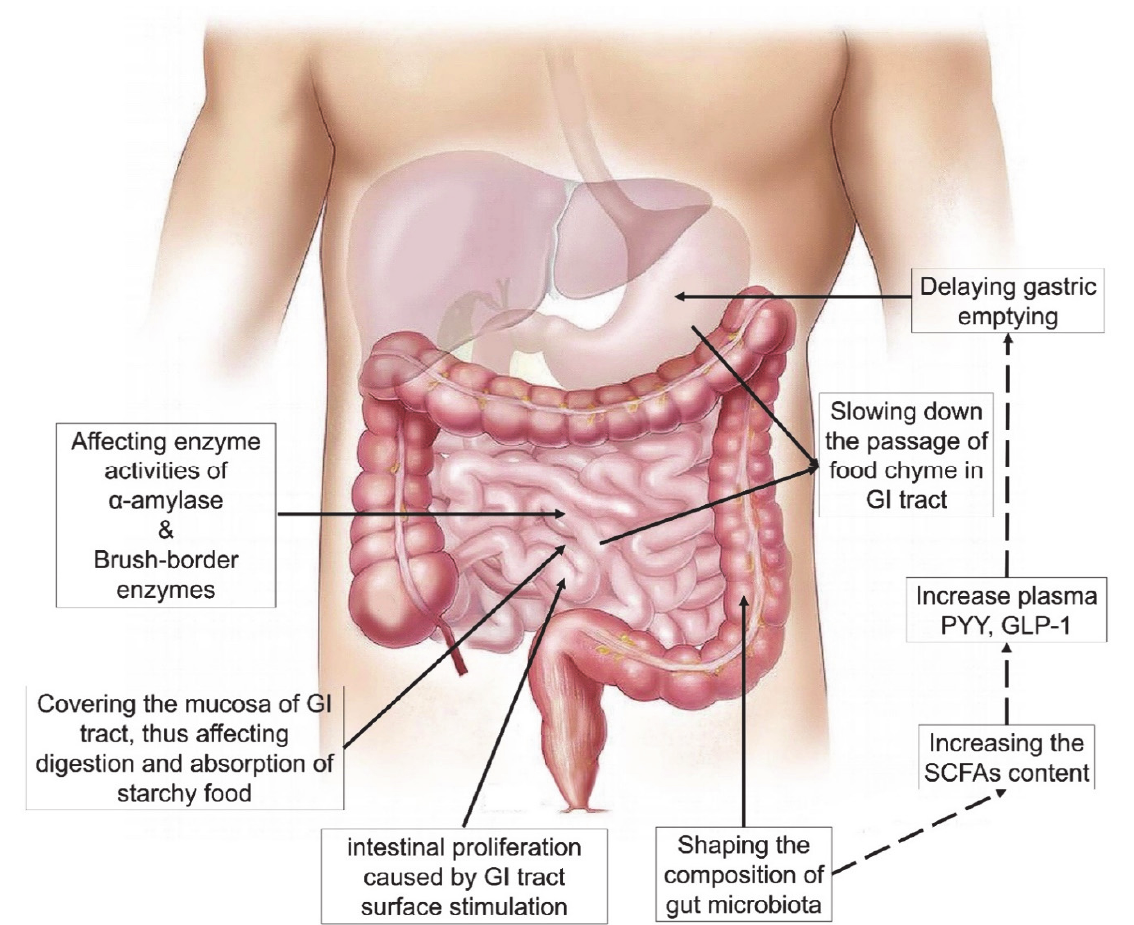
Figure 4. A summary of pectin’s regulating mechanisms in in vivo starch digestion and blood glucose level. Part of the graphic from https://pixabay.com/ (copyright-free, accessed on 2 June 2021).